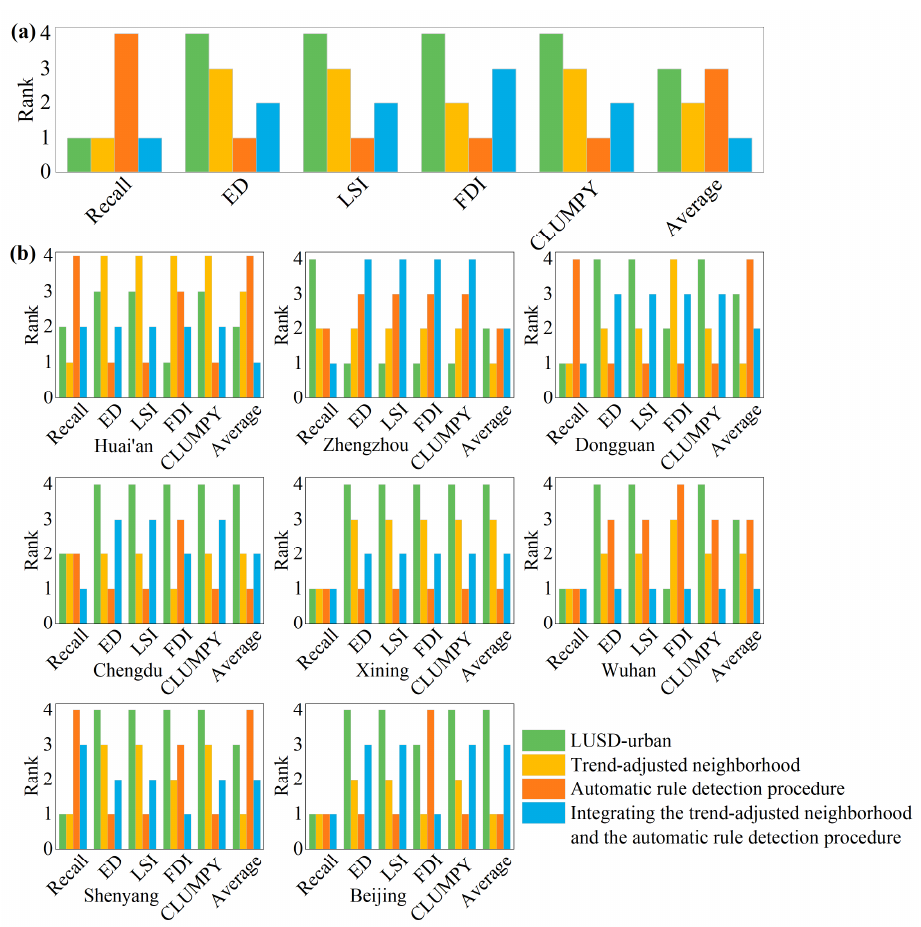
Figure 7. Comparison of the original and improved LUSD-urban models. ( a ) Average values for all sample cities; ( b ) values for eight sample